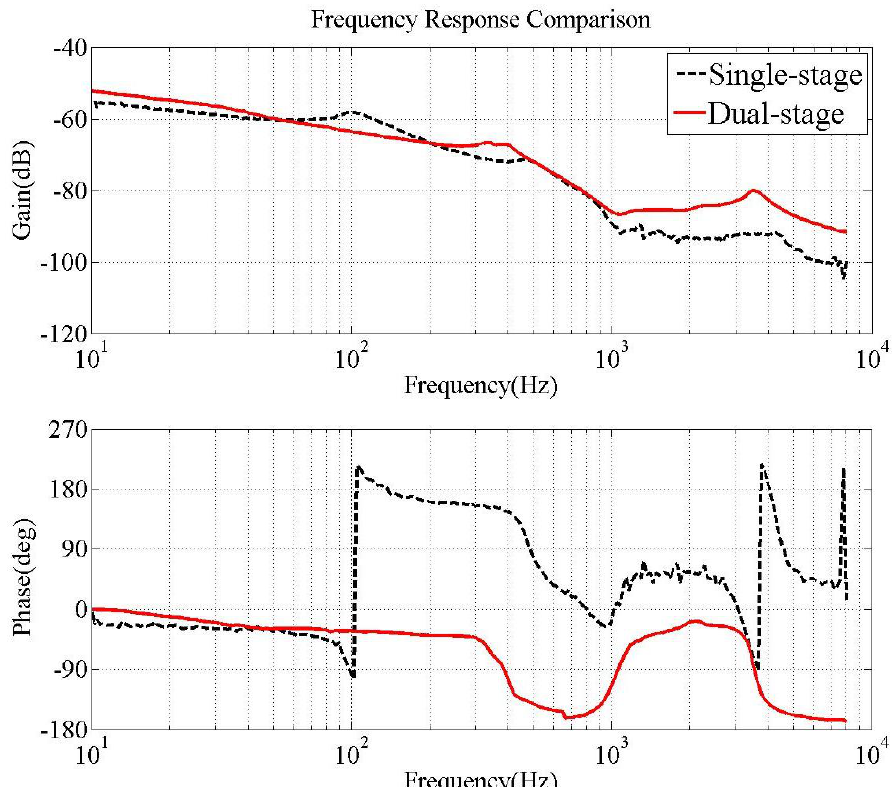
Figure 17. Single- and dual-stage actuated suspension frequency response: VCM input to head displacement (dash line); VCM and PZT combined actuation input to head displacement (solid